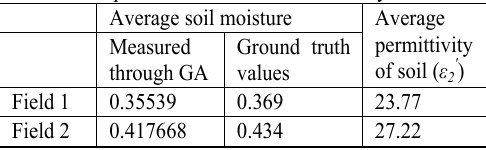
Table-I- Soil parameters retrived from two-layer model Average soil moisture Average